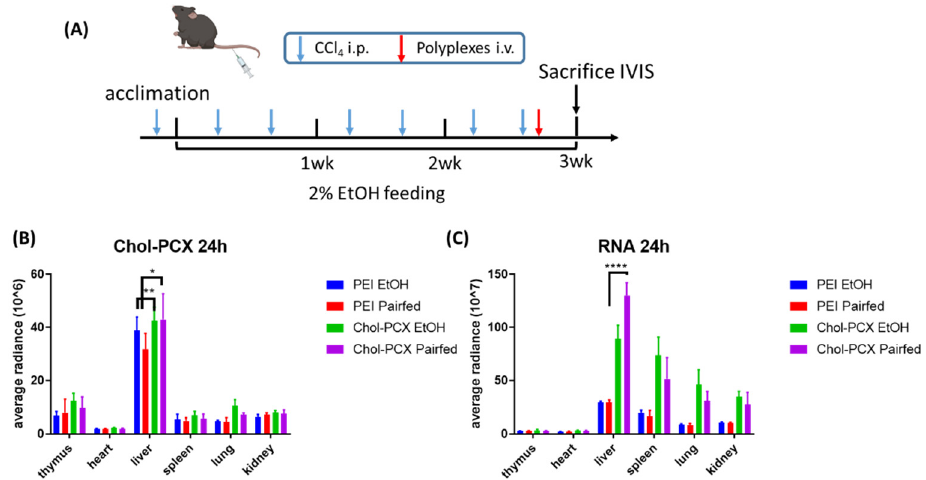
Figure 7. Biodistribution of Chol-PCX and PEI Cy5.5-siRNA nanoparticles. ( A ) Mice were treated with CCl 4 for 3 weeks and fed 2% EtOH or a control diet, with the intravenous (IV) injection of the nanoparticles at the end of feeding. ( B ) Distribution in different organs 24 h after the IV injection of nanoparticles. ( C ) RNA distribution in different organs 24 h after the IV injection of nanoparticles. Data were analyzed by two-way ANOVA followed by Tukey’s comparison test. Data are expressed as mean ± SD ( n = 6). * p < 0.05, ** p < 0.01, and **** p < 0.0001.